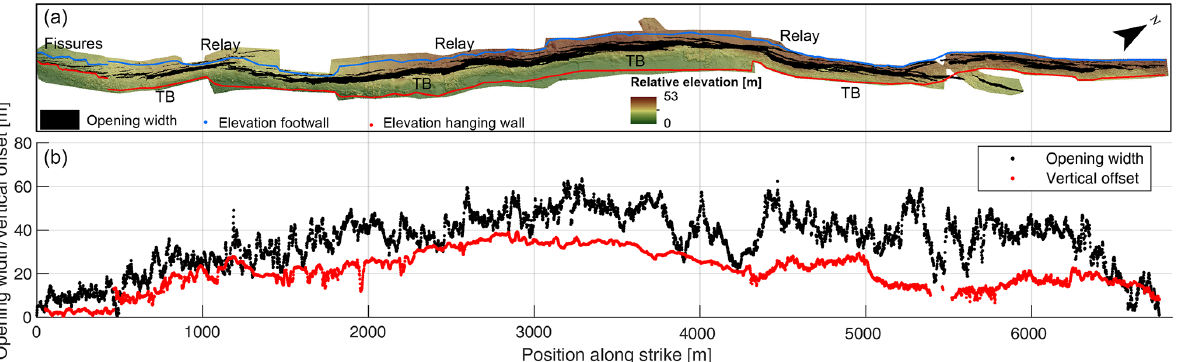
Figure 10. Fracture associated with the Thingvellir (Hengill) fissure swarm, also known as the Almannagjá fault. (a) DEM with the mapped opening width of the fractures. (b) Opening width (black) and vertical offset (red) plotted along strike. The x -axis scale is analogous to the scale in the DEM in panel (a) ; 64 ◦ 14 (cid:48) 33 (cid:48)(cid:48) N, 21 ◦ 8 (cid:48) 37 (cid:48)(cid:48) W. Projection of the DEM: WGS1984 UTM